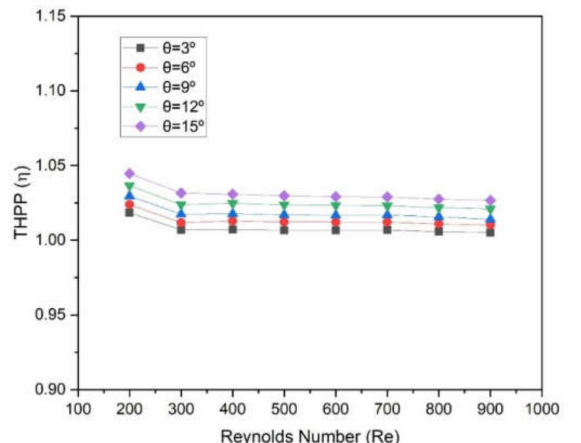
Figure 13. Variation in thermo-hydraulic performance parameter ( η ) of microchannel heat sinks with Reynolds numbers for different